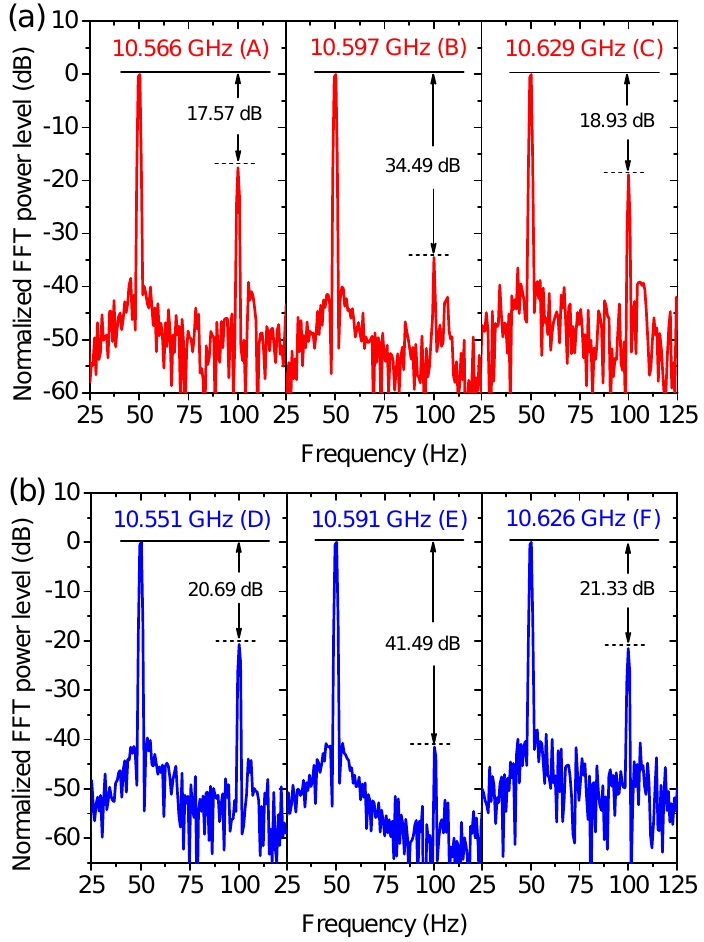
Figure 11. FFT spectra of the conventional ( a ) and engineered ( b ) BGS at the interrogation frequencies in